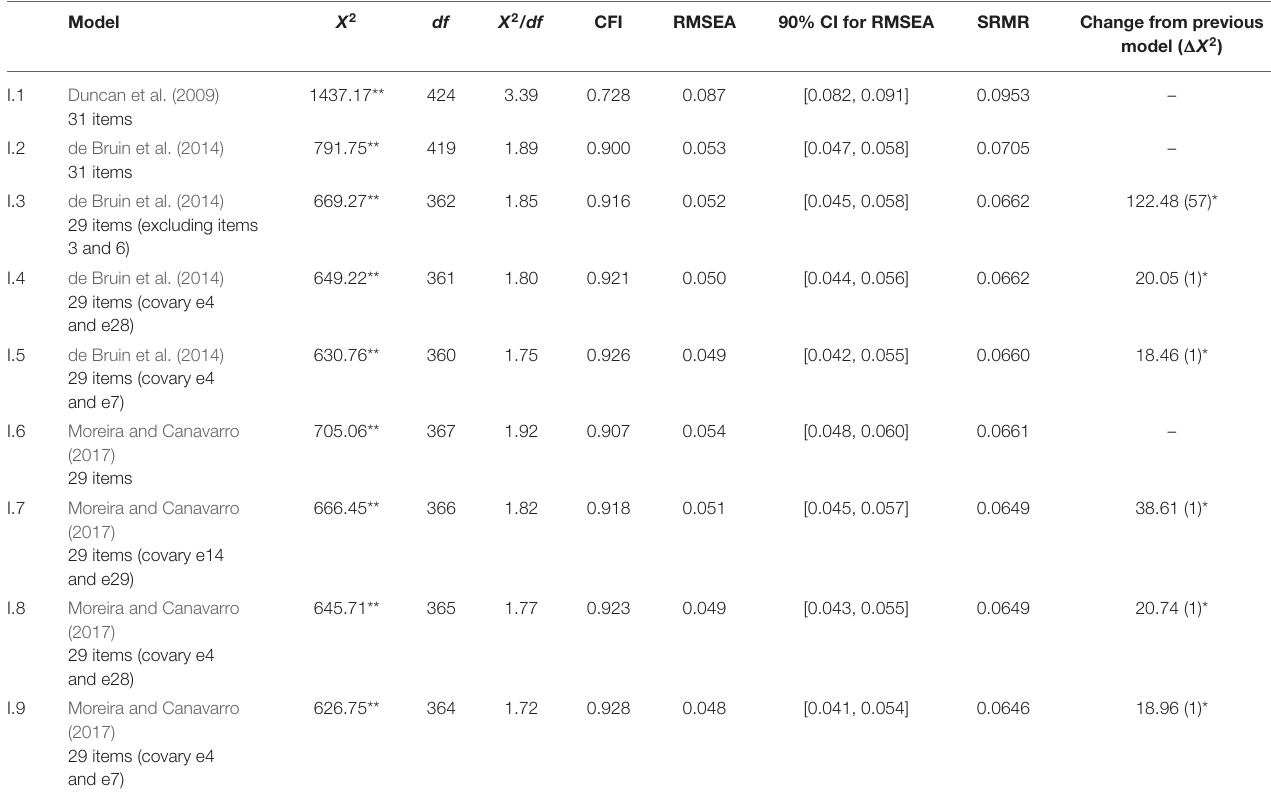
TABLE 3 | Fit indices from the confirmatory factor analyses, for mothers of infants ( n =